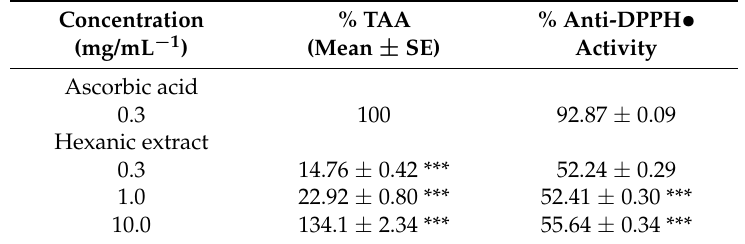
Table 2. Antioxidant activity of the hexanic extract of E. carlinae inflorescences in vitro.